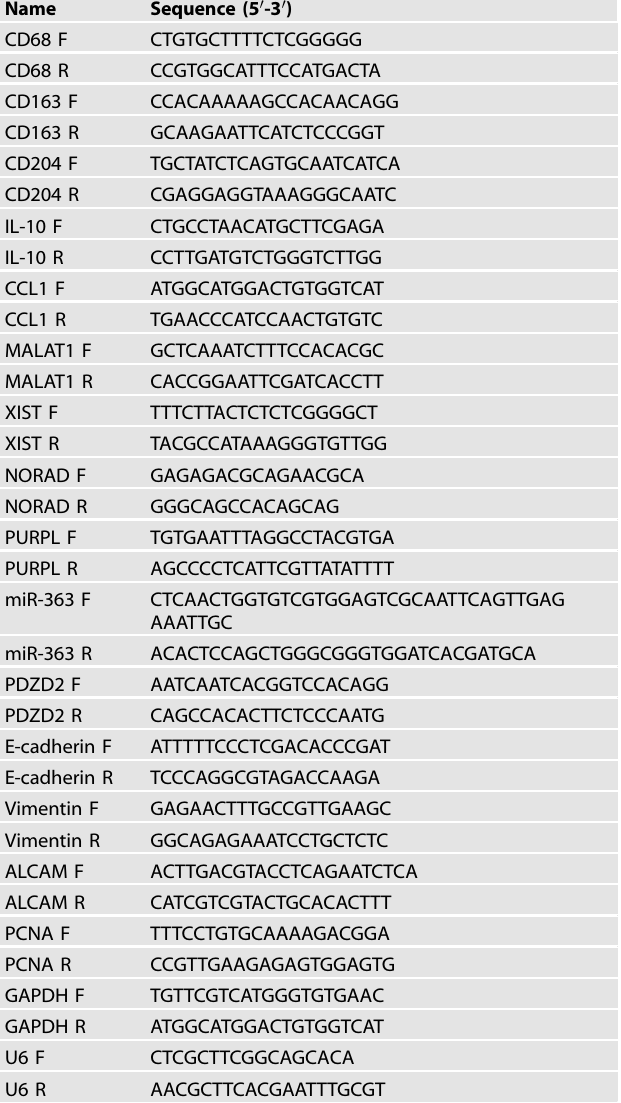
Table 1. The primers information for real-time